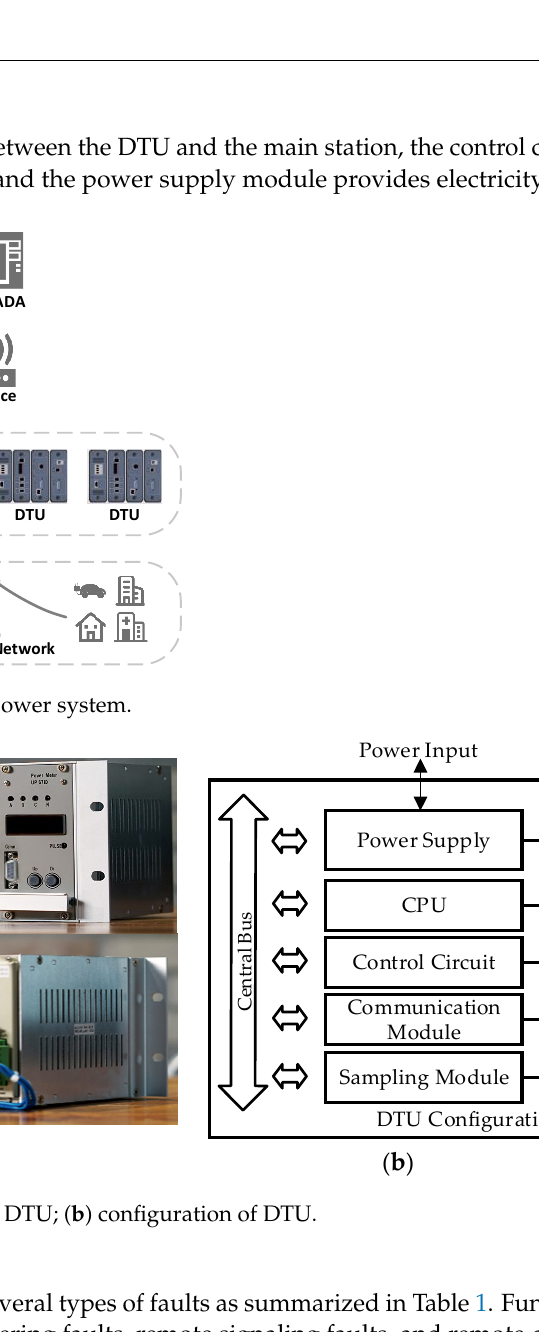
Figure 2. ( a ) Picture of DTU; ( b ) configuration of DTU.